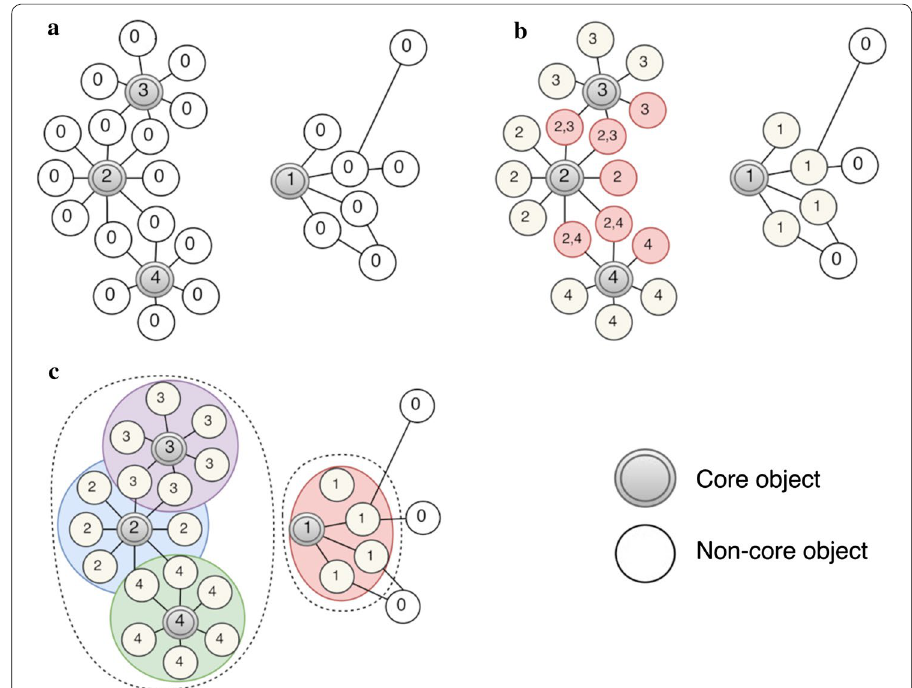
Fig. 3 Graphic representation of the clustering approach. a Initialization of cluster IDs. b Core objects propagate their cluster ID to their neighbors ( map phase). Nodes highlighted in red receive multiple messages. c Multiple cluster IDs received by the same node are aggregated ( reduce phase). Dotted lines represent the final clustering result, after some